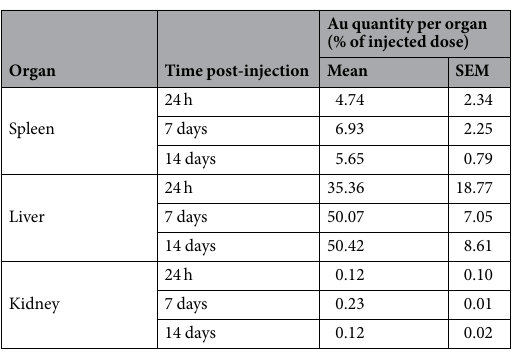
Table 2. Gold concentration expressed in percentage of injected dose in spleen, liver and